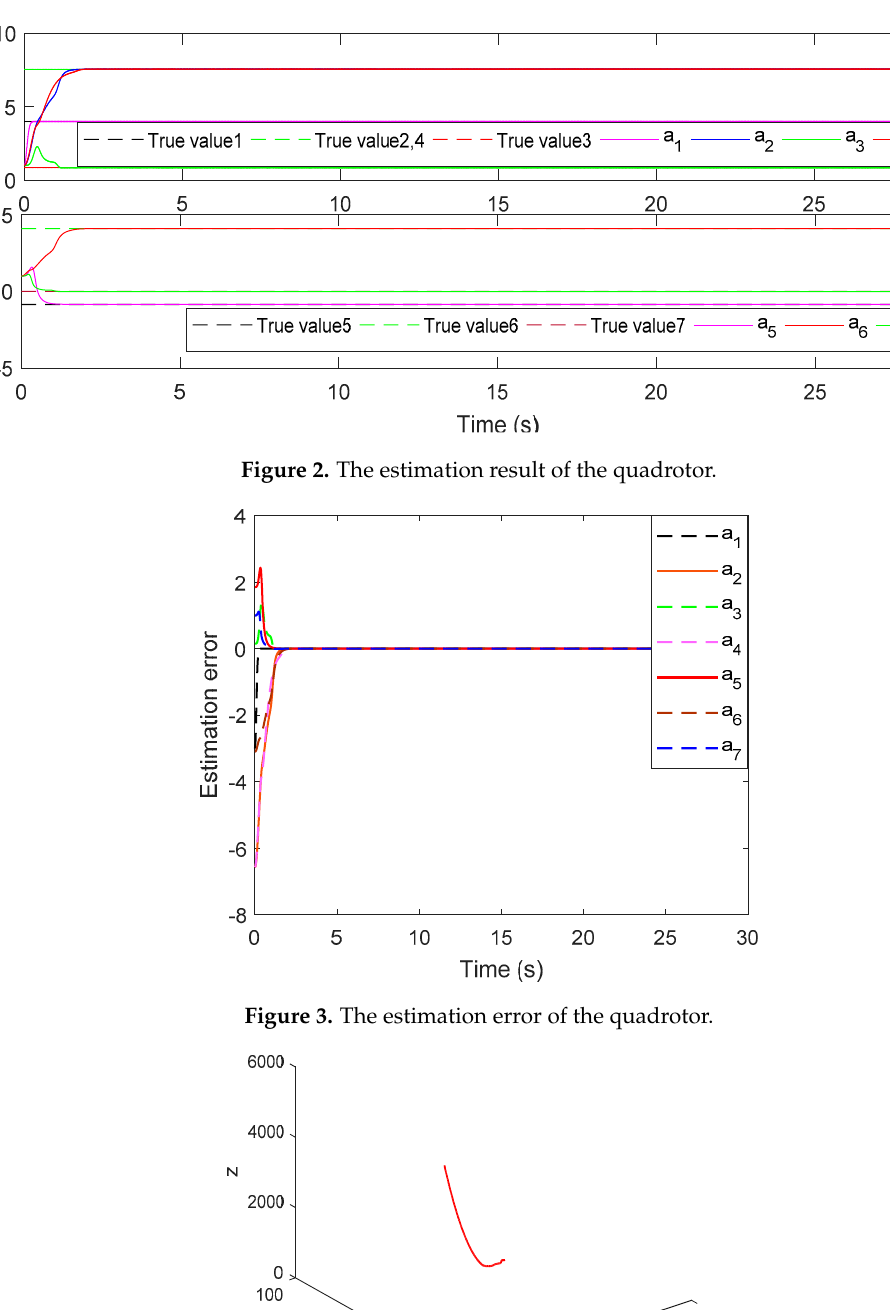
6 of 10 Table 1. Some physical parameters for the quadrotor. Parameter